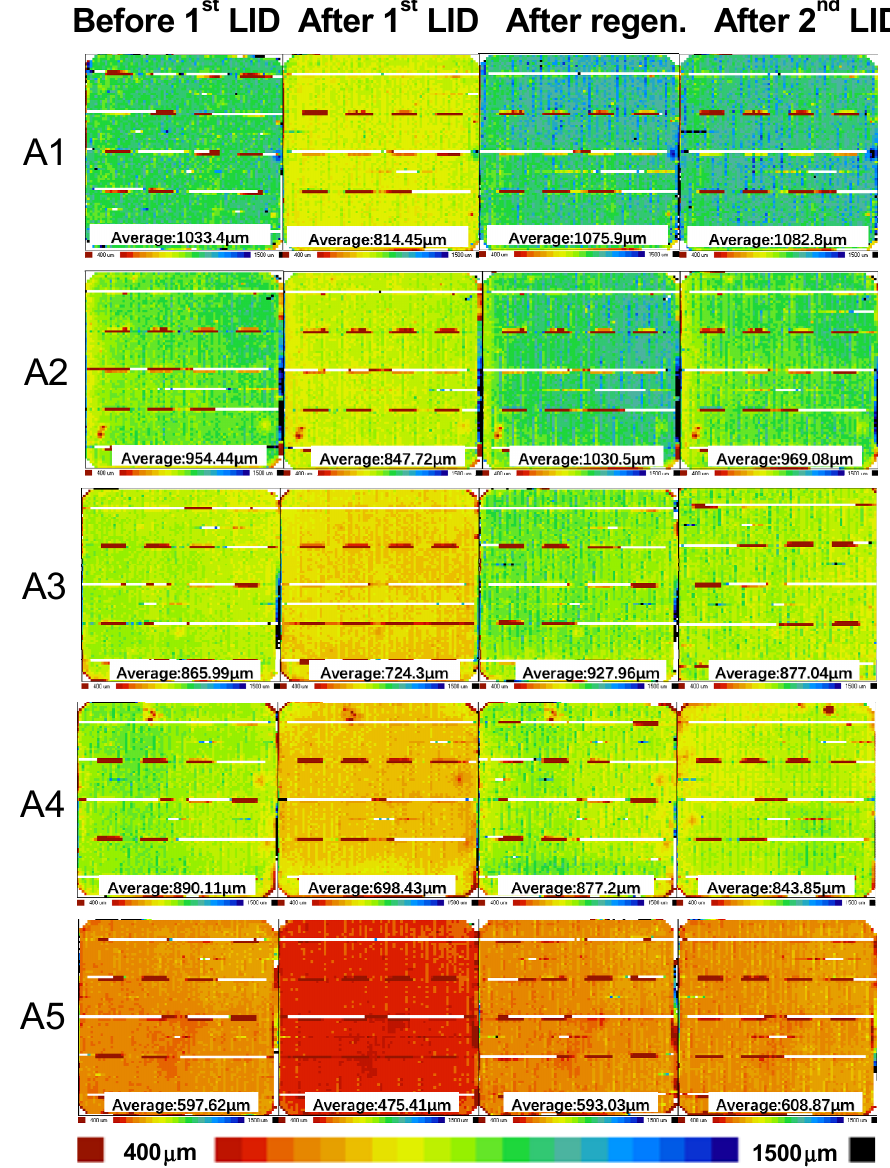
Figure 4. The minority carrier diffusion length mapping of the five groups of Al-BSF solar cells obtained by full-area LBIC scan at four breakpoints of treatments (before and after the 1st LID, after regeneration and the 2nd LID).